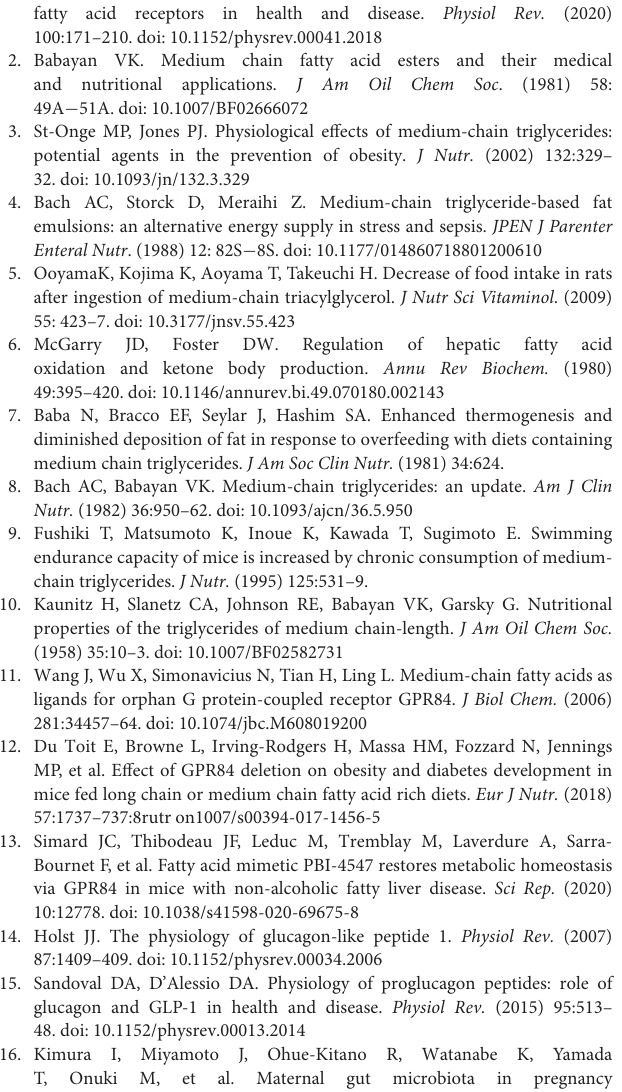
Supplementary Figure 2 | Plasma C10:0 levels under C10:0-supplemented high-fat diet (HFD)-fed condition. C10:0 levels in the plasma of HFD- or 5% C10:0-supplemented HFD-fed mice for 5 weeks (n = 8, 7). Samples which collected after fasting for 5 h were measured by liquid chromatography/mass spectrometry (LC/MS). Student’s t test; ∗∗ P < 0.01. All data are presented as the mean ± standard error of mean (SEM). C10:0, 5% decanoate (C10:0)-supplemented HFD. Supplementary Table 1 | Diet composition in medium-chain triglyceride (MCT) intake experiments. Lard, Lard diet; TriC8, octanoate (C8:0) triglyceride diet; TriC10, decanoate (C10:0) triglyceride diet; TriC12, dodecanoate (C12:0) triglyceride diet. Supplementary Table 2 | Diet composition in decanoate (C10:0) supplementation experiments. HFD, high-fat diet; C10:0, 5%